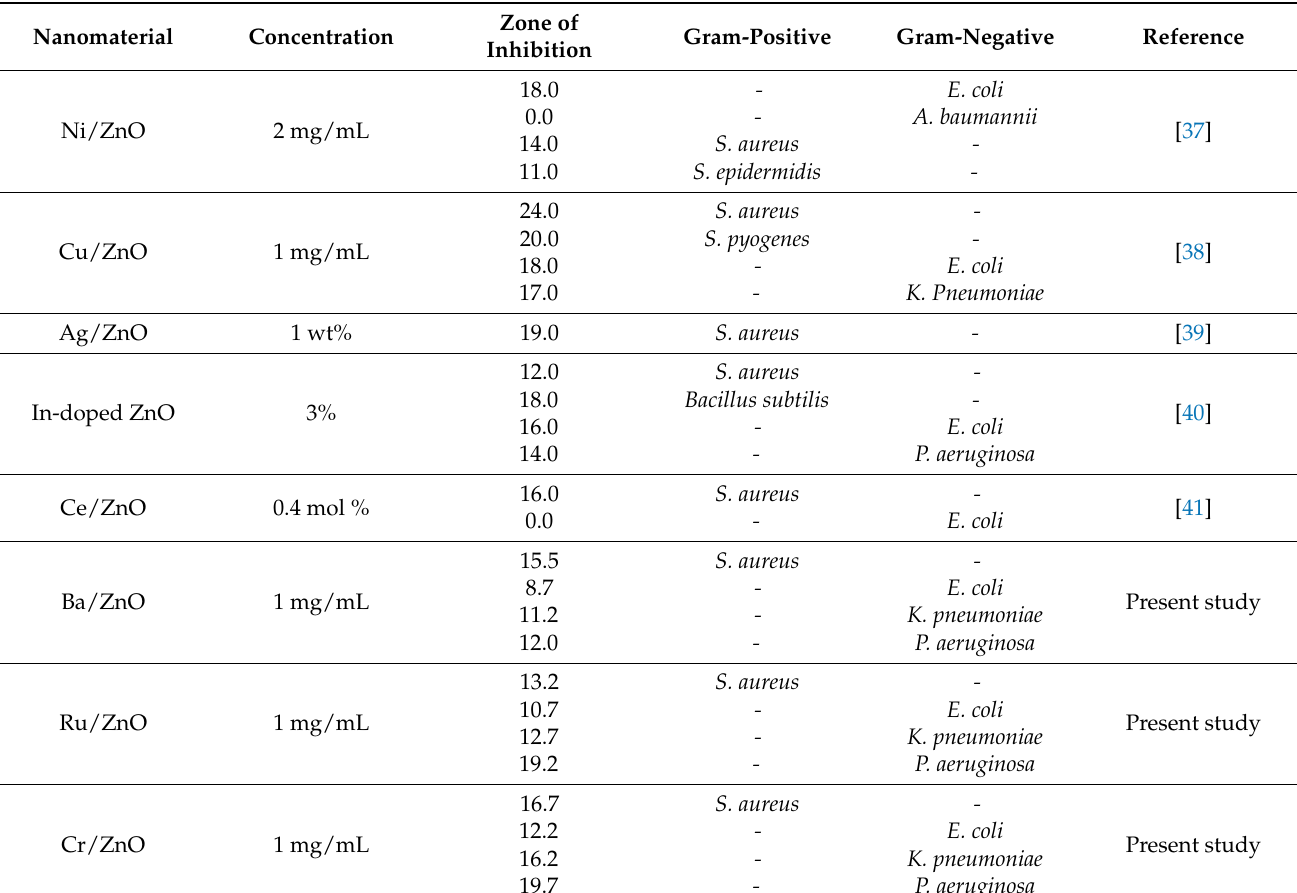
Table 2. The diameter of the inhibition zone against different microorganisms in ZnO doped with various metallic